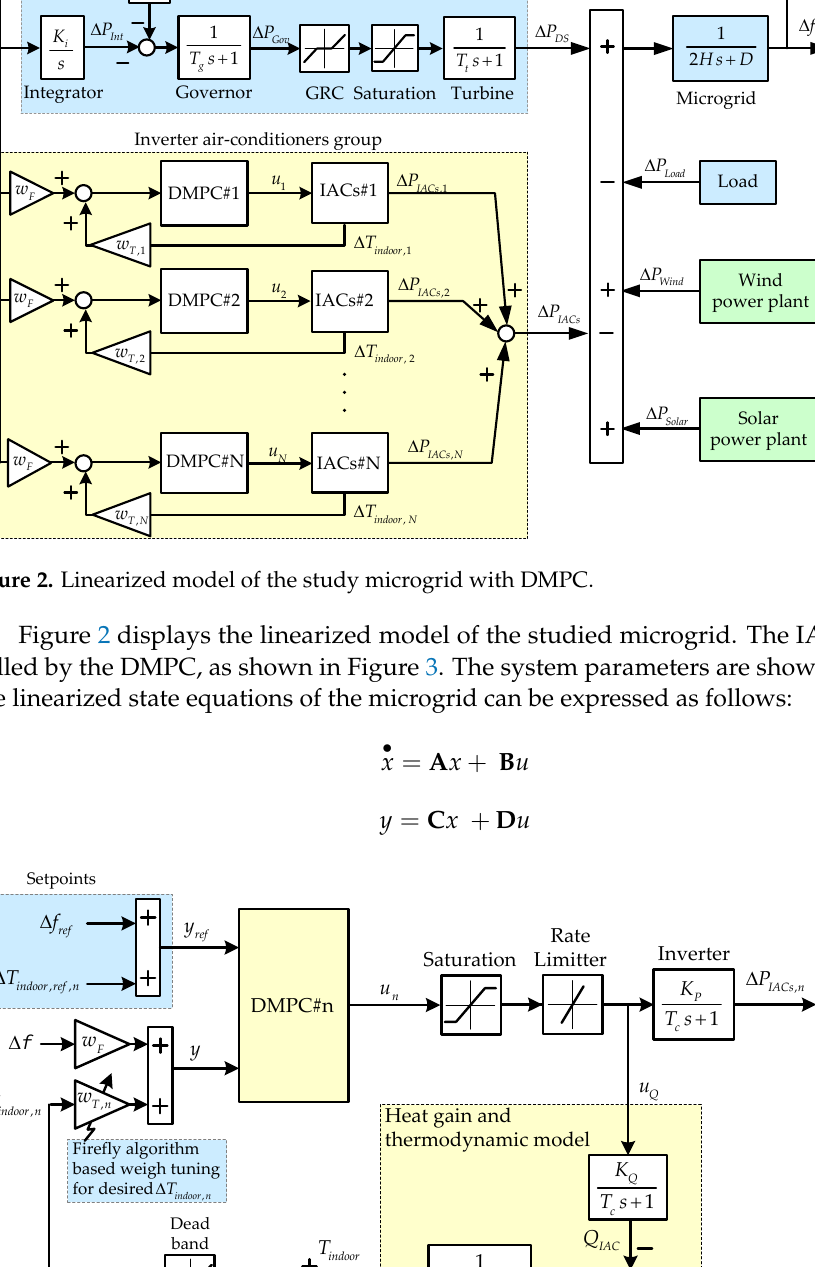
IACs in controlling the frequency deviation. The DMPC is used for controlling frequency and indoor temperature deviations simultaneously, as shown in Figures 1 and 2. Figure 1. Microgrid with DMPC for IACs control.